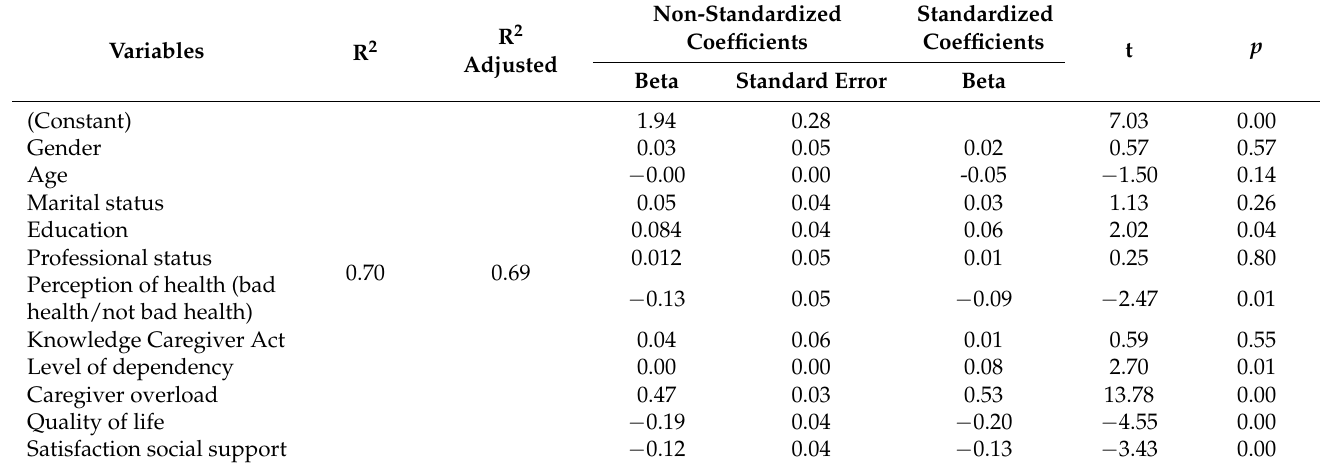
Table 12. Studying gender, age, marital status, education, employment status, quality of life, knowl- edge of caregiver law, level of dependency, and perceived burden as predictors of caregiver